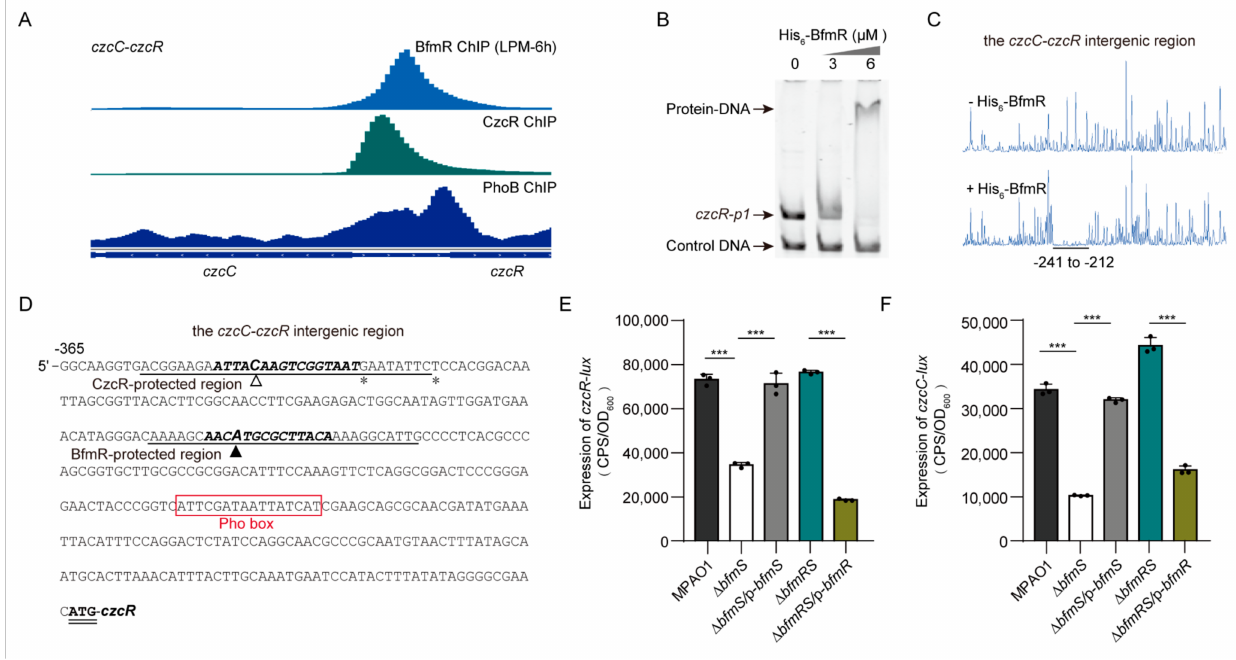
Figure 3. BfmR binds to and inhibits the promoter activity of czcR and czcC . ( A ) Pattern of BfmR, CzcR, and PhoB ChIP-seq peaks for the czcC - czcR intergenic region. The PhoB ChIP data were obtained from NCBI Gene Expression Omnibus (GEO) database under accession number GSE128430 [58]. ( B ) EMSA showing that the N-terminal His 6 -tagged BfmR (His 6 -BfmR) binds to the promoter of czcR (i.e., czcR-p1 ). DNA fragments C- bfmR serves as a negative control. ( C ) Electropherograms show the protection pattern of the czcC - czcR intergenic region after digestion with DNase I following incubation in the absence (-) and presence (+) of His 6 -BfmR (6 µ M). The protected regions (relative to the start codon of czcR ) are underlined. ( D ) czcR promoter sequence with a summary of the results of DNase I footprint assays and ChIP-seq experiments. The CzcR- and BfmR-protected regions are underlined as indicated and the asterisk shows the DNase I hypersensitivity site described in Figure S2E. Hollow and solid triangle indicates the location of the summits of CzcR- and BfmR ChIP-seq peaks, respectively. The potential Pho box [59] is highlighted by square frame, and the starting codon (ATG) of czcR is in bold and double underlined. Sequences that match the MEME motif of CzcR (see in Figure 2B) and BfmR (see in Figure 1C) are in bold and italic. ( E , F ) The promoter activity of czcR (in E) and czcC (in F) in wild type (WT) MPAO1 and its derivatives grown in MM supplemented with 50 µ M ZnCl 2 at 37 ◦ C for 6 h. Data points are shown in black dots, and results represent means ± SD (n = 3 biological replicates; *** p < 0.001, Student’s two-tailed t -test). MPAO1, ∆ bfmS , and ∆ bfmRS harboring an empty pAK1900 vector as a control; p- bfmS and p- bfmR respectively denote pAK1900- bfmS and pAK1900- bfmR (Table